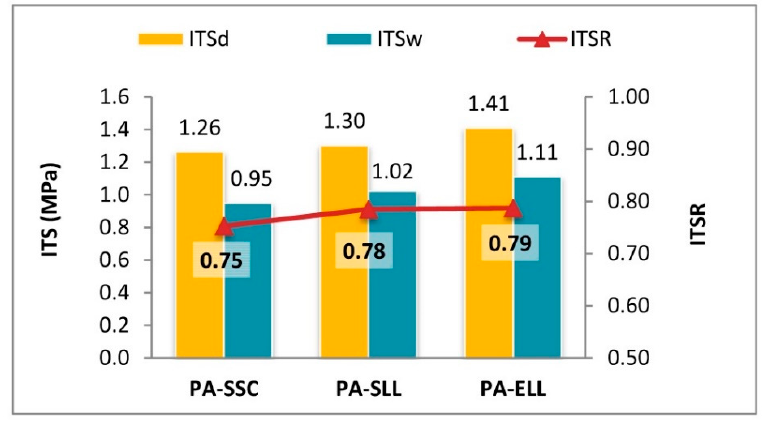
Figure 10. Moisture susceptibility.